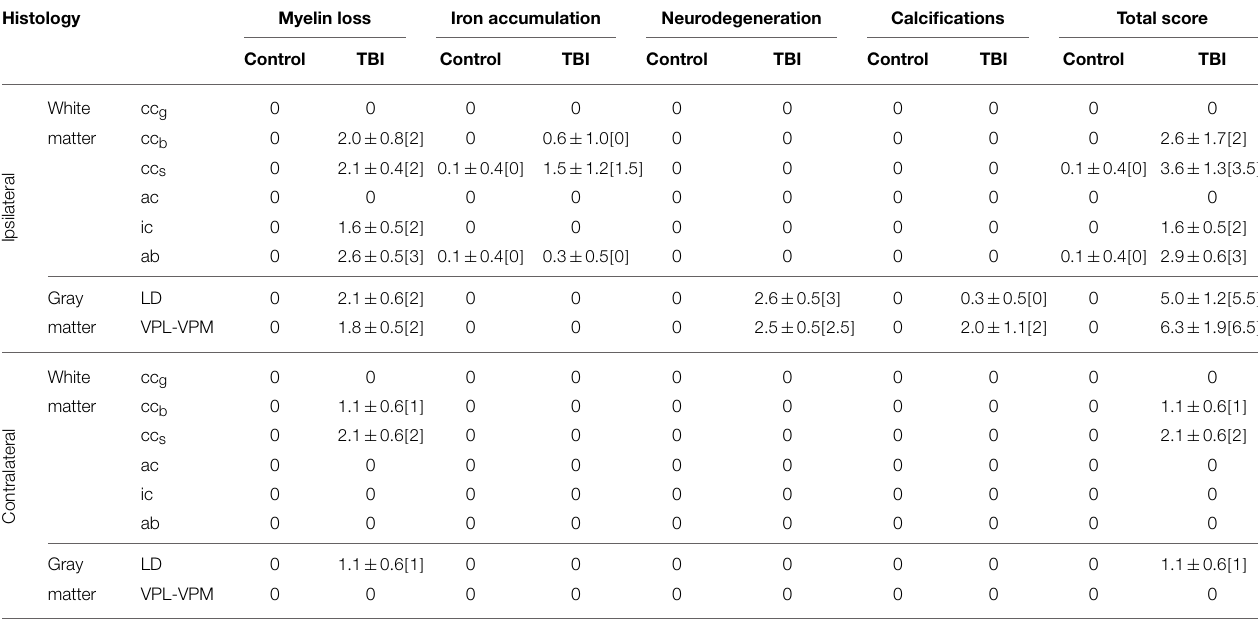
TABLE 2 | Semi-quantitative scores comparing controls and rats after TBI. Histology Myelin loss Iron accumulation Neurodegeneration Calcifications Control Control Control Control